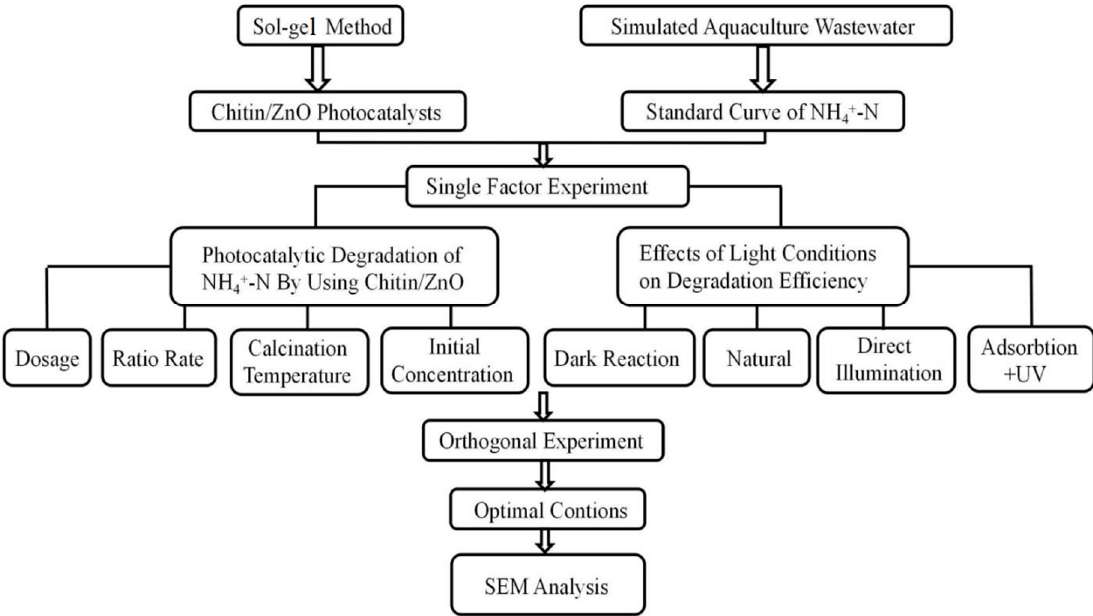
Figure 2. The technology roadmap for the preparation and degradation of Chitin/ZnO.